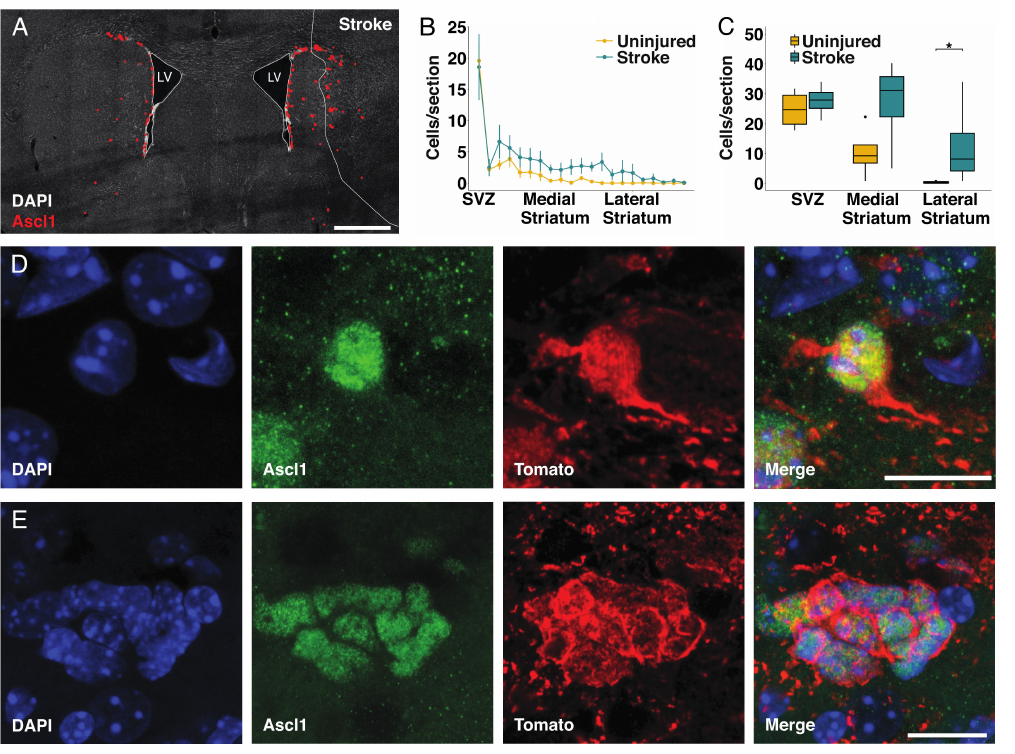
Figure 2. Astrocytes are more e ffi ciently recruited to the neurogenic lineage when blocking Notch-signaling: ( A ) Overview of transient amplifying progenitor cells in the uninjured and injured hemisphere seven weeks after stroke. Red dots are positioned to overlap with Ascl1 + cells for better visualization (scalebar = 500 µ m); ( B ) Analysis of the number of Ascl1 + / Tomato + cells in animals with deletion of Rbpj specifically in astrocytes. For each animal, four sections spanning throughout the lesion have been selected, and the average number of cells per section has been compared with the uninjured hemisphere from the same animal. To make the data comparable between animals, the distance from the striatum has been converted in percentage coordinates, where 0 represents the subventricular zone (SVZ), and 100 represents the lateral end of the striatum. The transition between the SVZ and medial striatum was placed at 10% and the one between medial and lateral striatum at 50%. The number of Ascl1 + cells in the stroke side is significantly higher (paired t-test, mean ± SEM; p = 0.028); ( C ) The number of transient amplifying progenitor cells in the lateral striatum is significantly higher in the stroke side compared to the uninjured (the data were analyzed using a paired two-way ANOVA, which allows the concomitant analysis of number and location of cells of interest within the striatum; data are presented as mean ± SD p = 0.041); ( D , E ) Examples of single cells; ( D ) Examples of clusters; ( E ) Ascl1 + / Tomato + cells found in the penumbra of the stroke area in di ff erent animals (scalebar = 10 µ m in D and 15 µ m in E